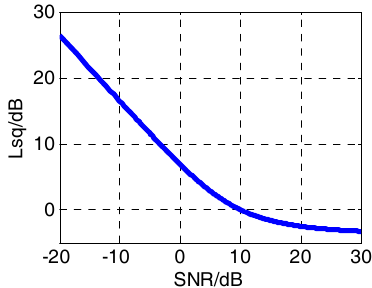
Figure 8. The relationship between squaring loss and the signal-to-noise ratio (SNR) of correlation results.